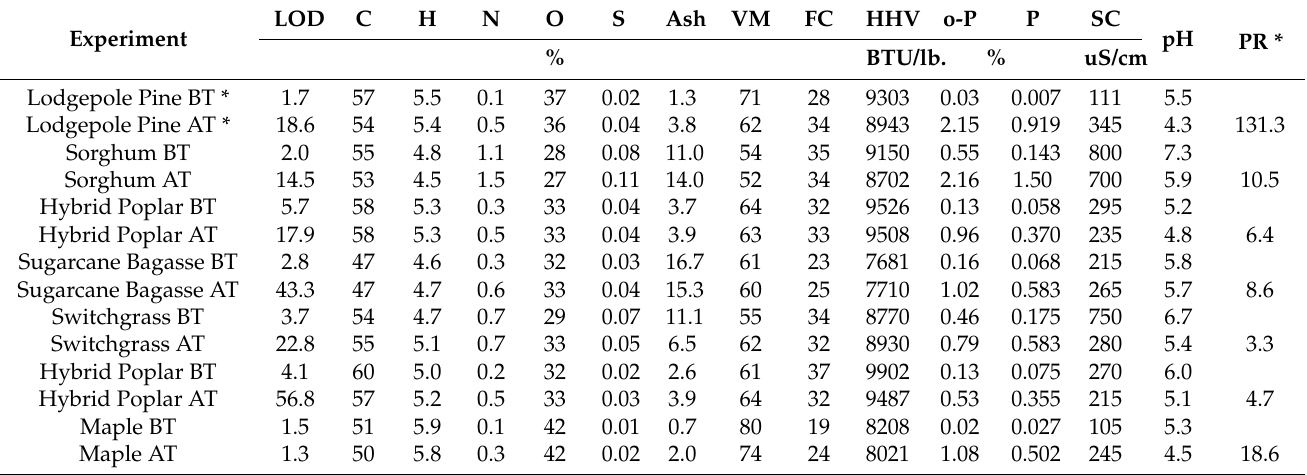
Table 2. Results of biomaterial elemental and proximate analyses before and after laboratory water treatment